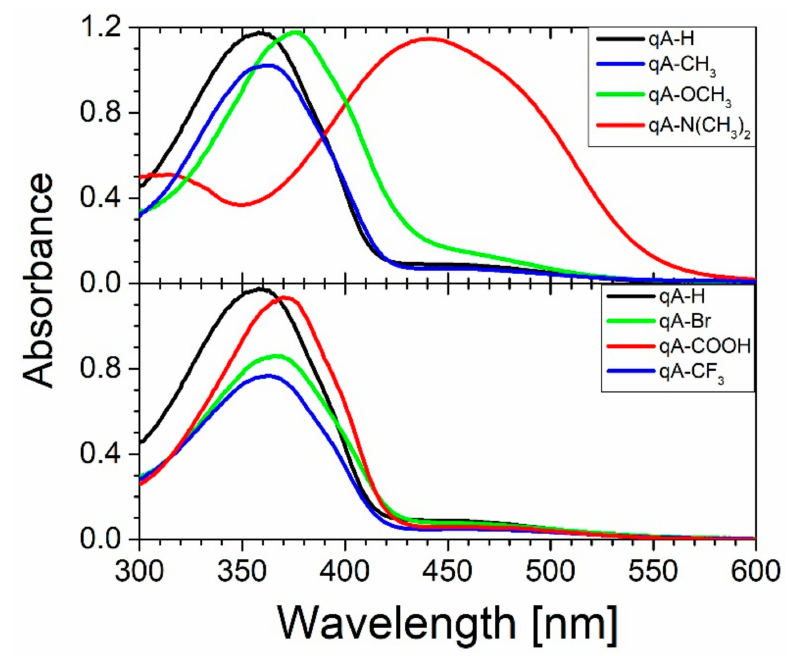
Figure 3. Absorbance spectra of quinoline azo-dye polymers with various electron donating and electron withdrawing substituents.